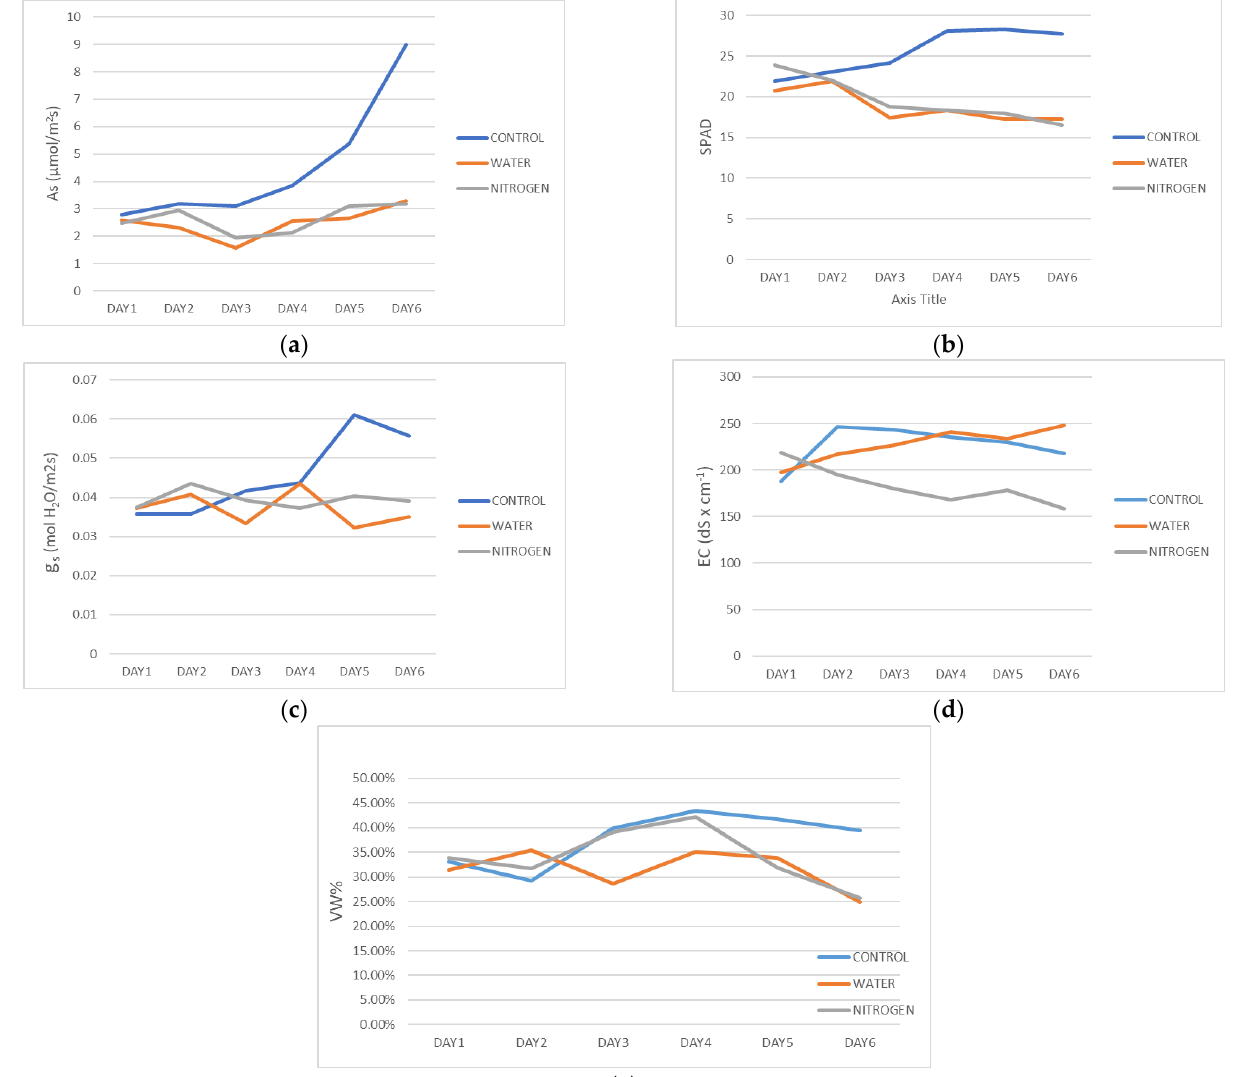
Figure 7. Average daily evolution of ( a ) photosynthetic efficiency, ( b ) chlorophyll content, ( c ) stomatal conductance, ( d ) electric conductivity, and ( e ) water volume for healthy plants (Control), water − stressed plants (Water) and nitrogen − stressed plants (Nitrogen). Days 1–6. Table 4. Results of the statistical analysis comparing the physiological parameters of the plants and the growth environment of the three treatments (Control, Water, and Nitrogen). The columns represent the sample size (N), mean values (Mean), standard deviation (SD), and degrees of freedom between the groups (df1) and within the groups (df2), F − test (F), and level of significance ( p − value). The letters (‘ a ’ and ‘ b ’) indicate significant differences in energy consumption between the two treatments at a significance level of p <